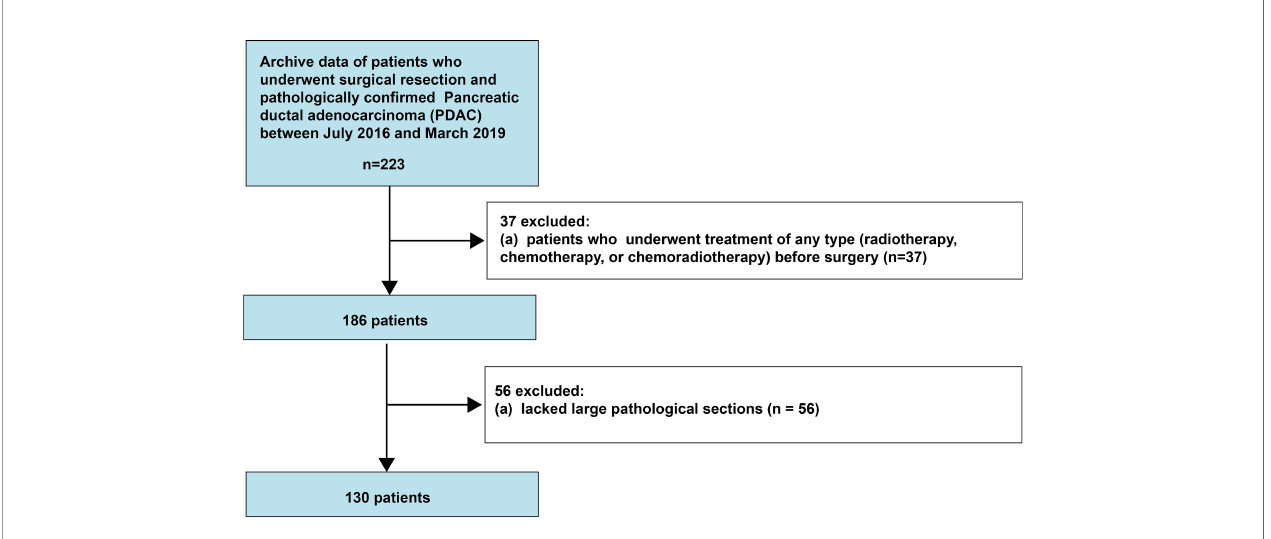
FIGURE 1 | Flowchart indicating the patient selection